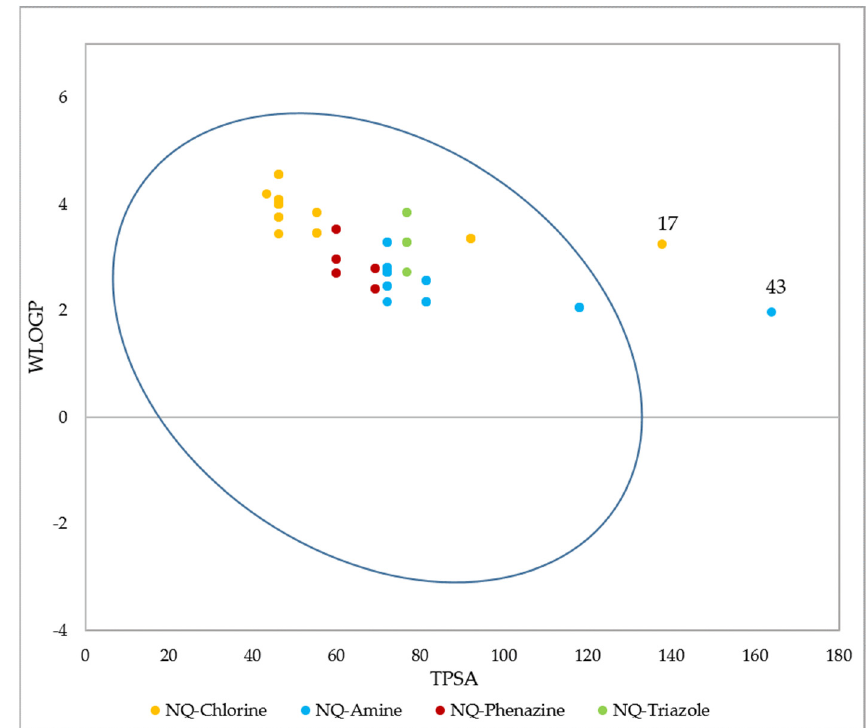
Figure 13. BOILED-Egg (adapted with permission from Ref. [108]) evaluation of gastrointestinal absorption for the 68 1,4-naphthoquinone derivatives. Molecules inside the oval indicate that they have GI permeability.